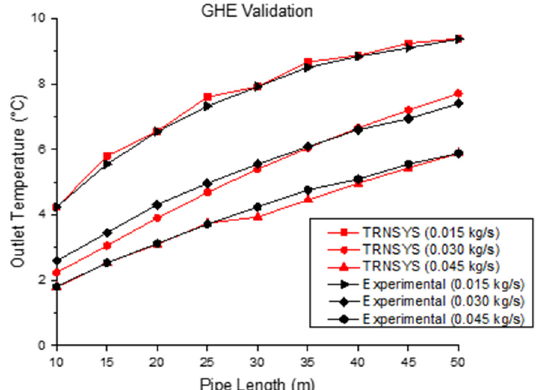
Figure 9. Comparison of the pipe length effect in the outlet temperature of the simulator and experimental results.